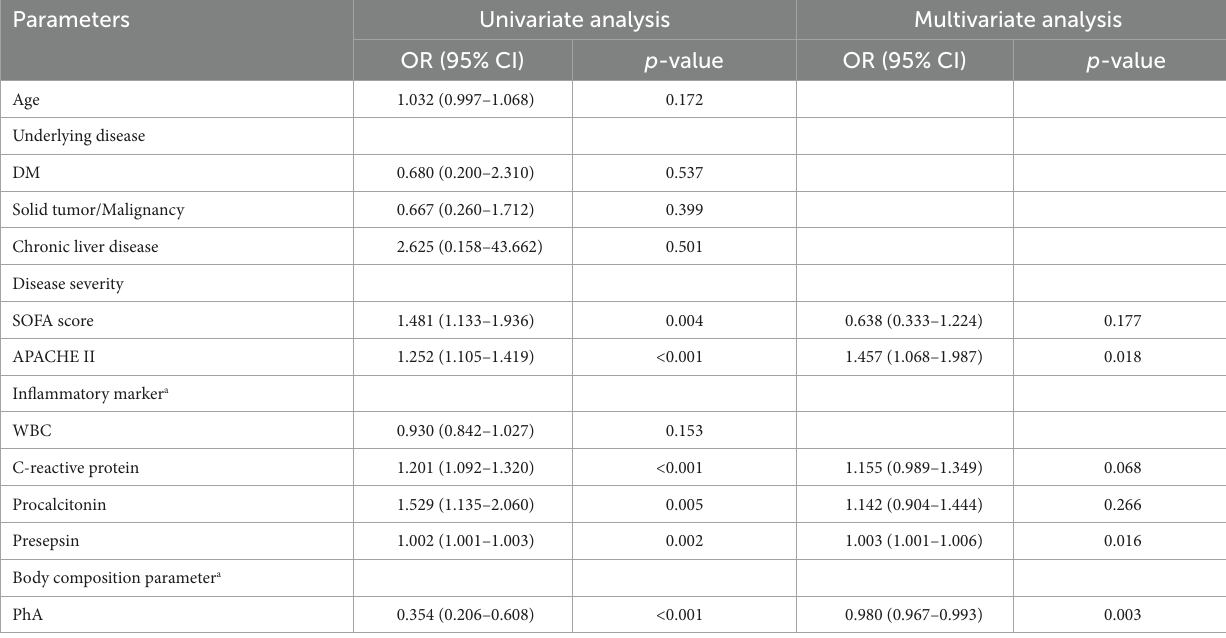
TABLE 4 Predictors of postoperative infections in patients who underwent abdominal surgery by univariate and multivariate logistic regression analysis in females.